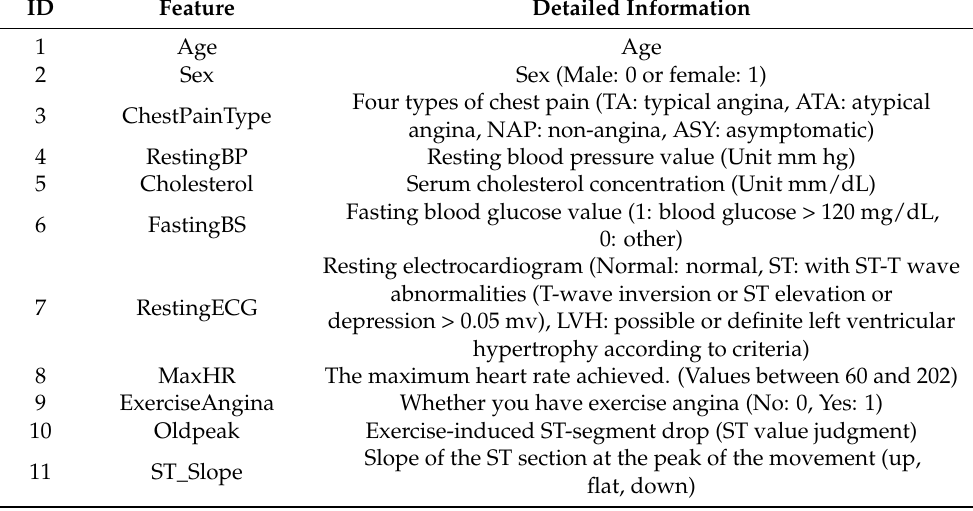
Table 1. Heart Dataset.